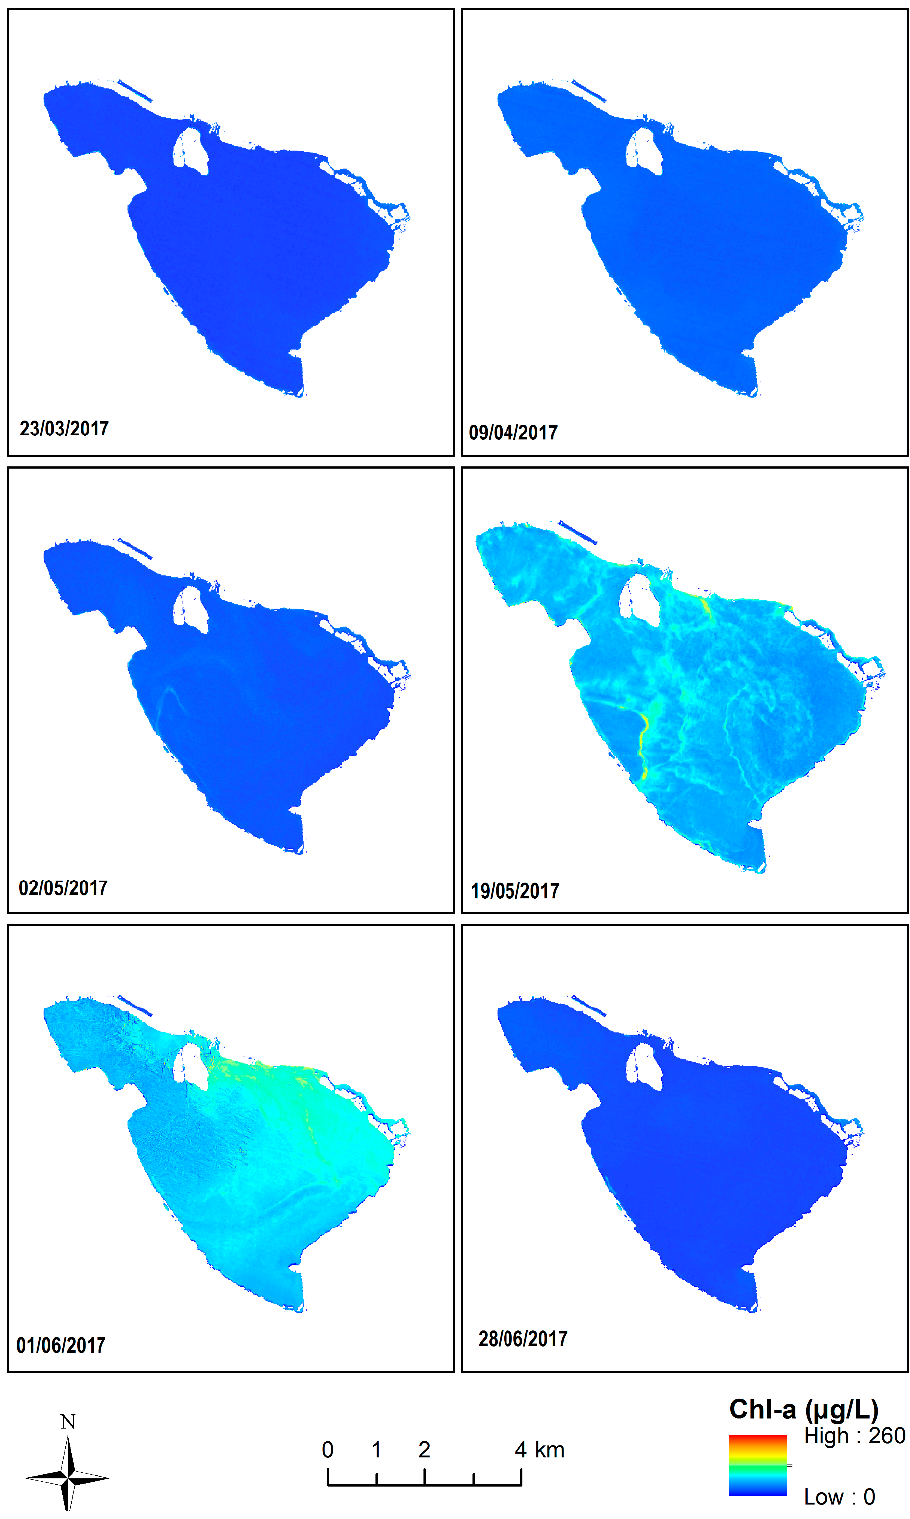
Figure 6. Outbreak of chl- a concentrations during March–June 2017. Only the available images without any cloud contamination have been processed.